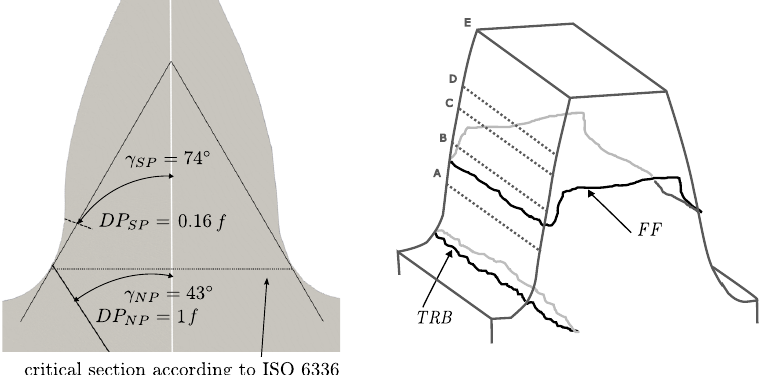
Figure 6. Position and early nucleation direction of the cracks for the reference NP and the shot-peened SP gears. Tooth root bending (TRB) and Flank Fracture (FF) failures according to the